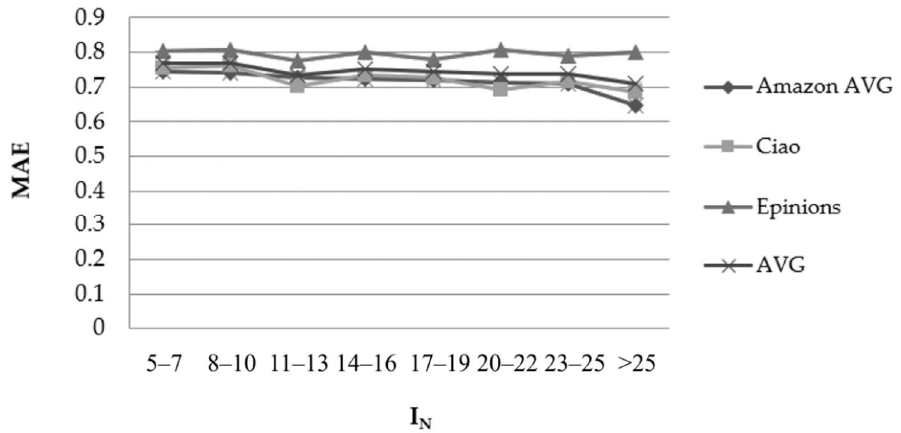
Figure 5. Effect of the I N –feature in the rating prediction MAE when using the PCC user similarity